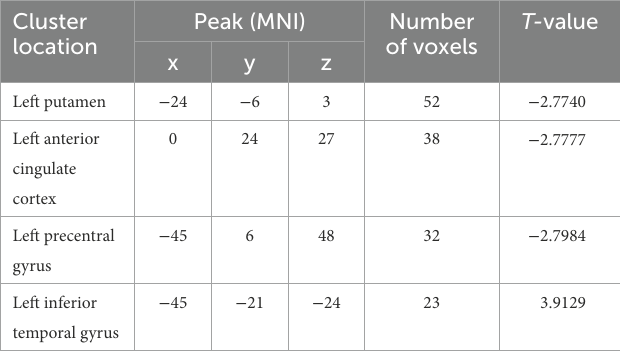
TABLE 5 Regions with abnormal ReHo values in the patients.